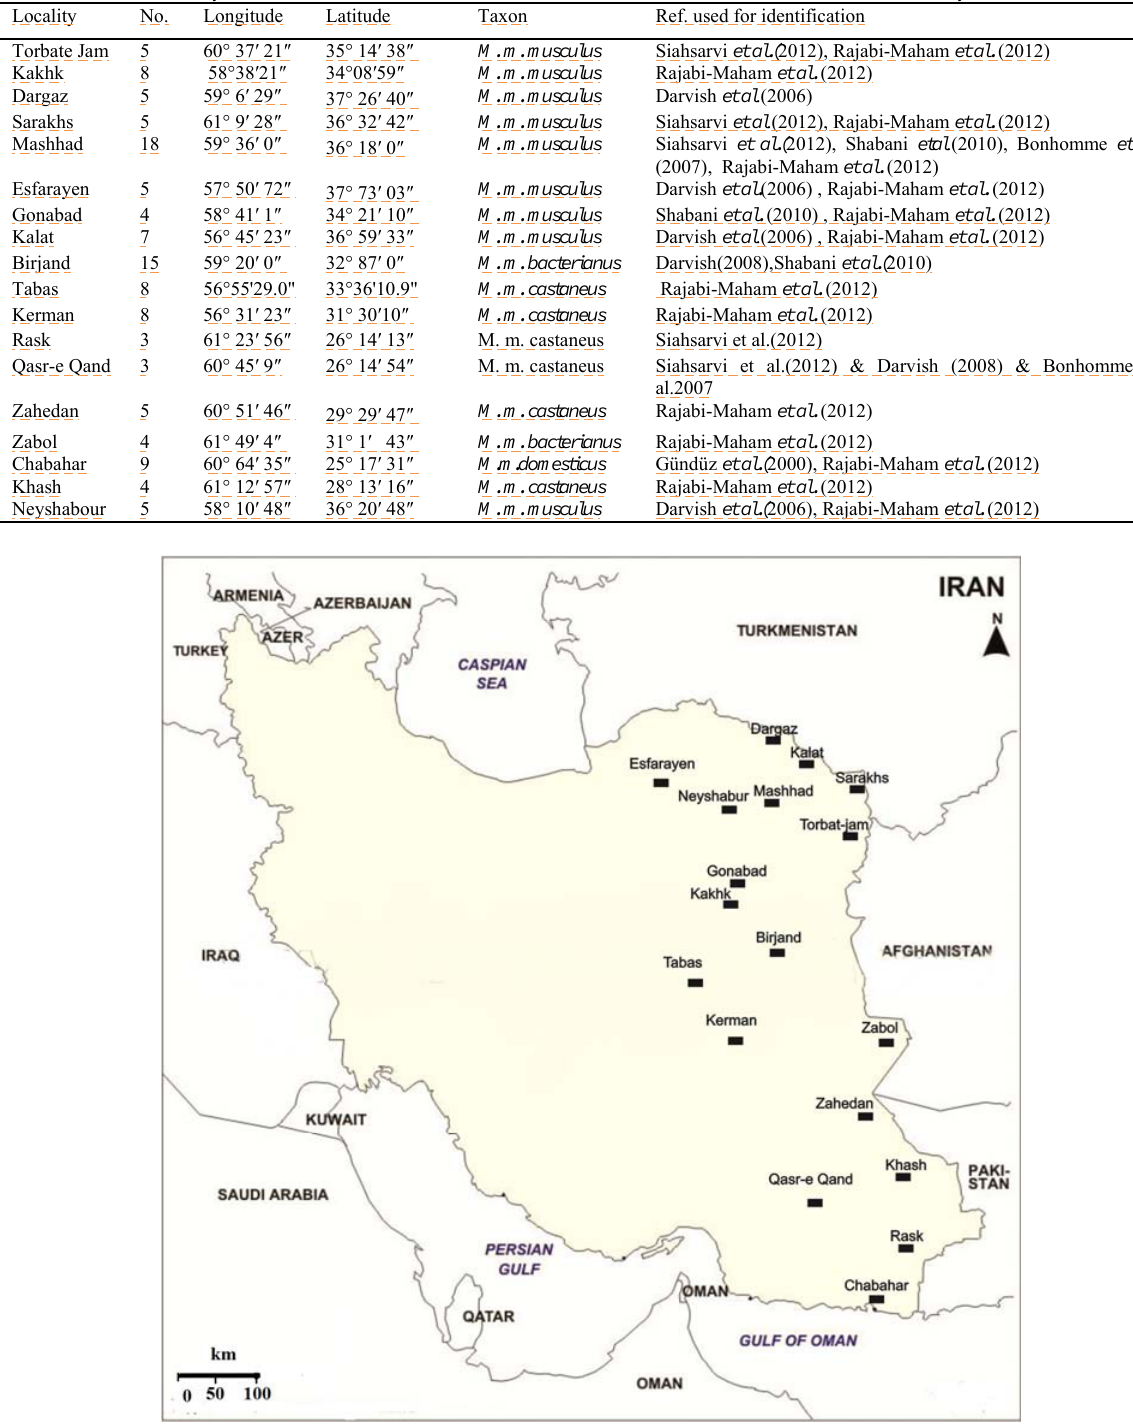
F IGURE 1. Map samples of M. musculus used in this study. Black boxes were referred to locality. Details of the samples are given in Table